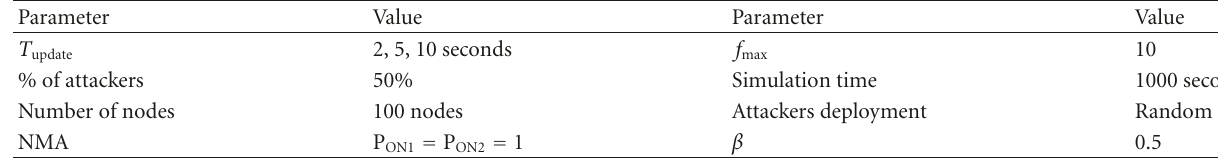
Table 3: Simulation parameters for T update variation experiments.